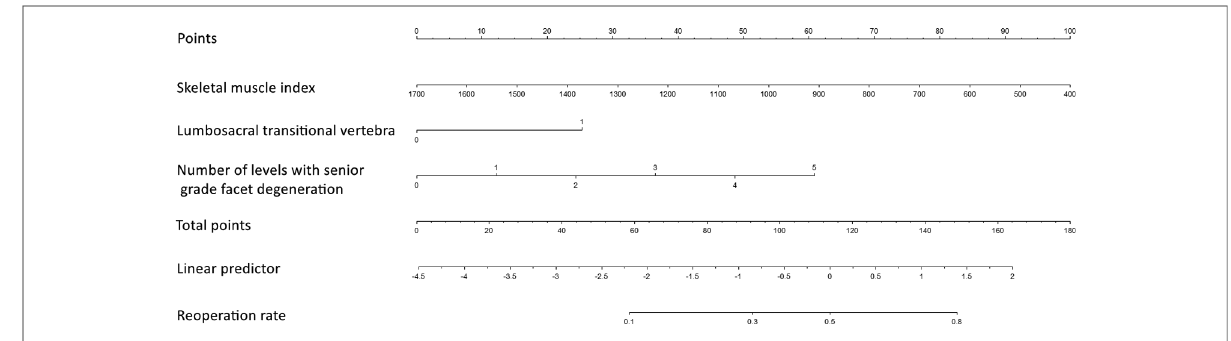
FIGURE 3 Nomogram for predicting reoperation risk in patients who underwent percutaneous transforaminal endoscopic lumbar decompression.